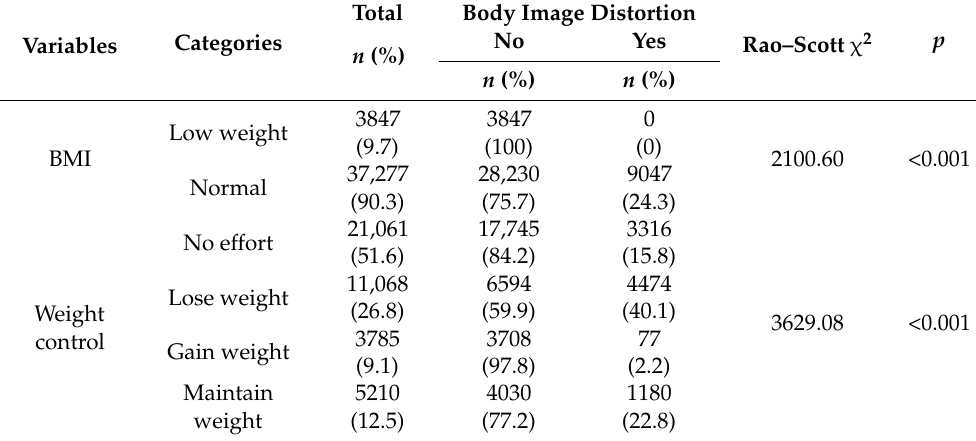
Table 2. Differences in body image distortion by weight control ( n =